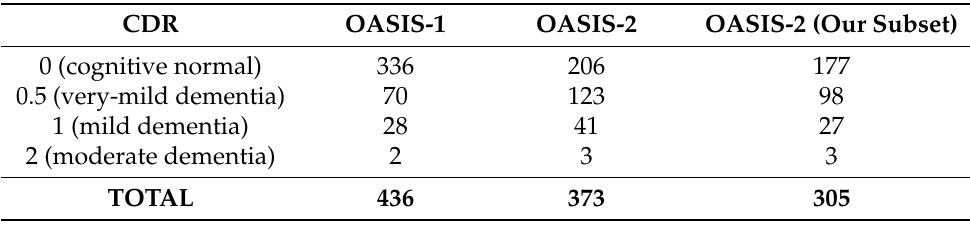
Table 1. Number of samples for the OASIS-1 and OASIS-2 datasets considering the CDR value as a